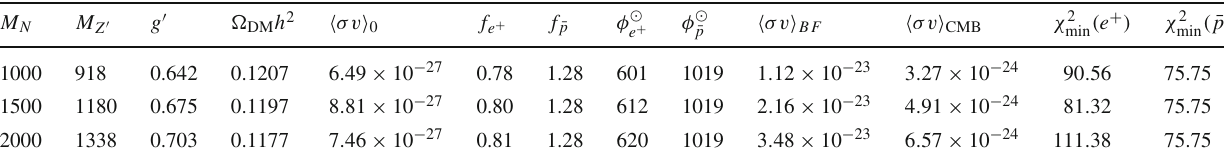
Table 3 The DM information for benchmarks of N N → Z (cid:3) Z (cid:3) anni- hilation channel. Here we choose h N = 0 . 5 and (cid:12) σv (cid:13) 0 (in units of cm 3 s − 1 ) denotes the thermally averaged DM annihilation cross sec- tion at freeze out, (cid:12) σv (cid:13) BF ≡ BF × (cid:12) σv (cid:13) 0 denotes annihilation cross